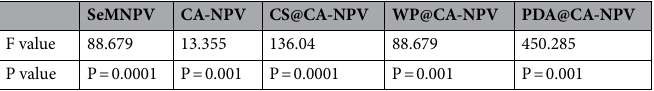
Table 2. Ten days mortality values subjected to ANOVA.